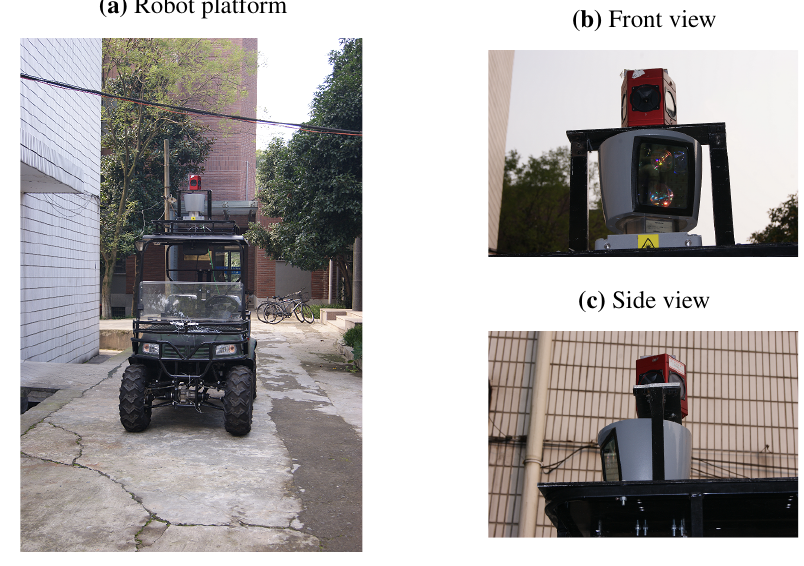
Figure 5. The robotic platform and the sensors in our experiment. ( a ) is the robotic platform, which is equipped with a Ladybug3 camera and a 3D Velodyne HDL-64E LIDAR, ( b ) shows the front view of the two sensors, and ( c ) is the side